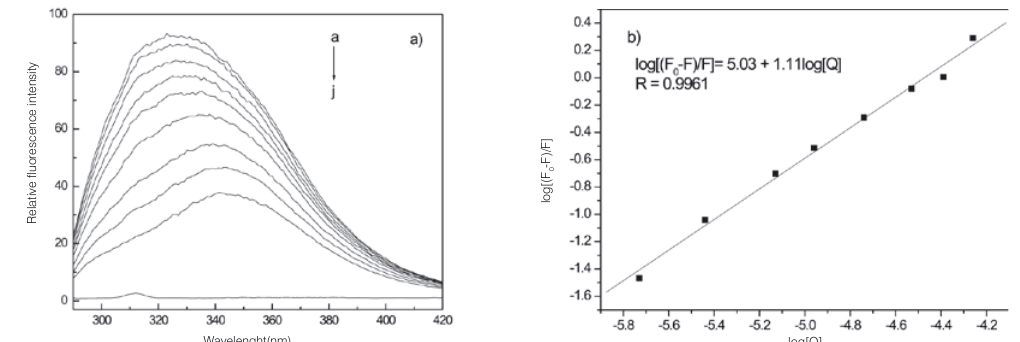
Figure 3. Fluorescence quenching of imperatorin - BSA system a. Effect of imperatorin on fluorescence spectra of BSA. pH=7.40 T=298K (a) 1.0 × 10 -6 mol L -1 BSA; (b to i) 1.0 × 10 -6 mol L -1 BSA in the presence of 1.8, 3.7, 7.3, 11.0, 18.3, 2, 9.3, 40.3, 55 × 10 -6 mol L -1 imperatorin; (j) 4.0 × 10 -5 mol L -1 imperatorin; b. Double-logarithm plots of imperatorin - BSA system at